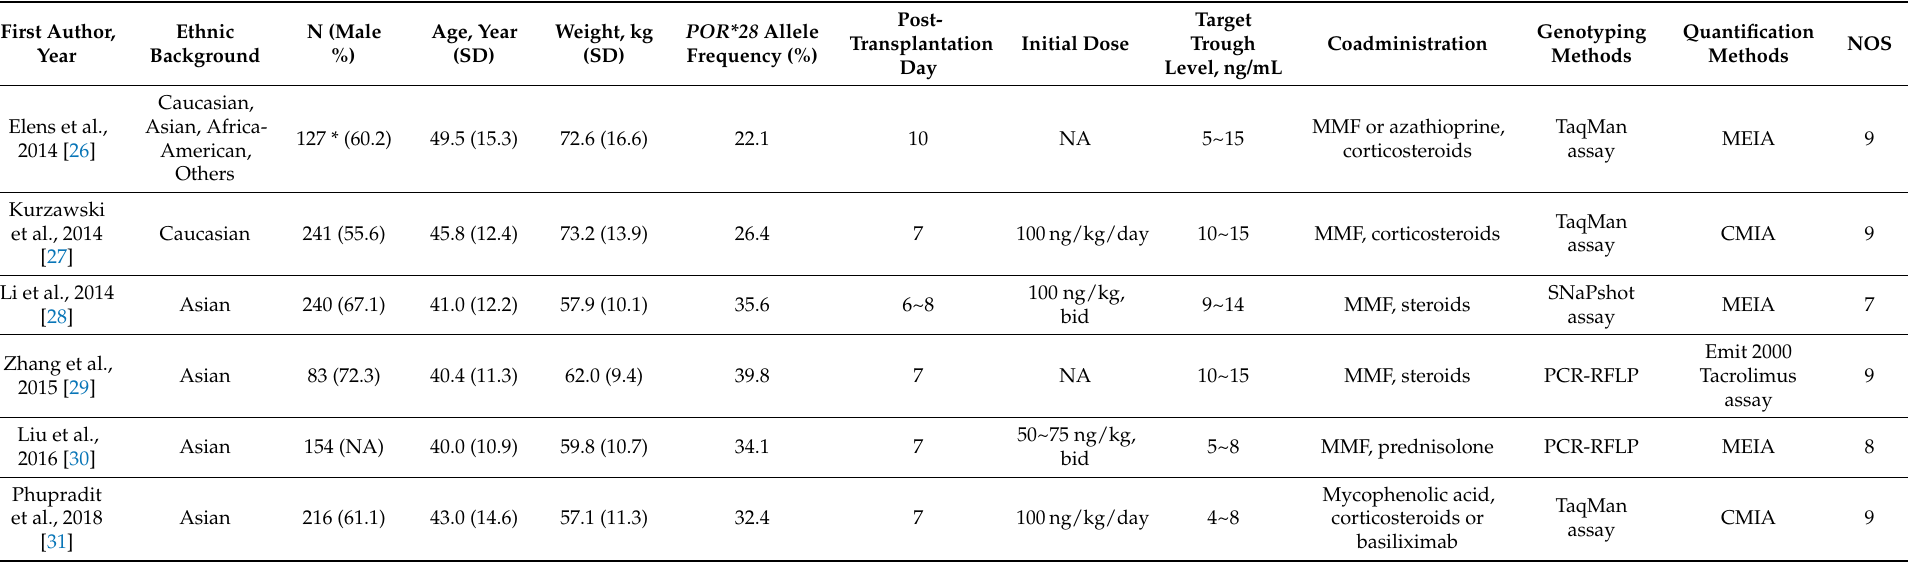
Table 2. The characteristics of included